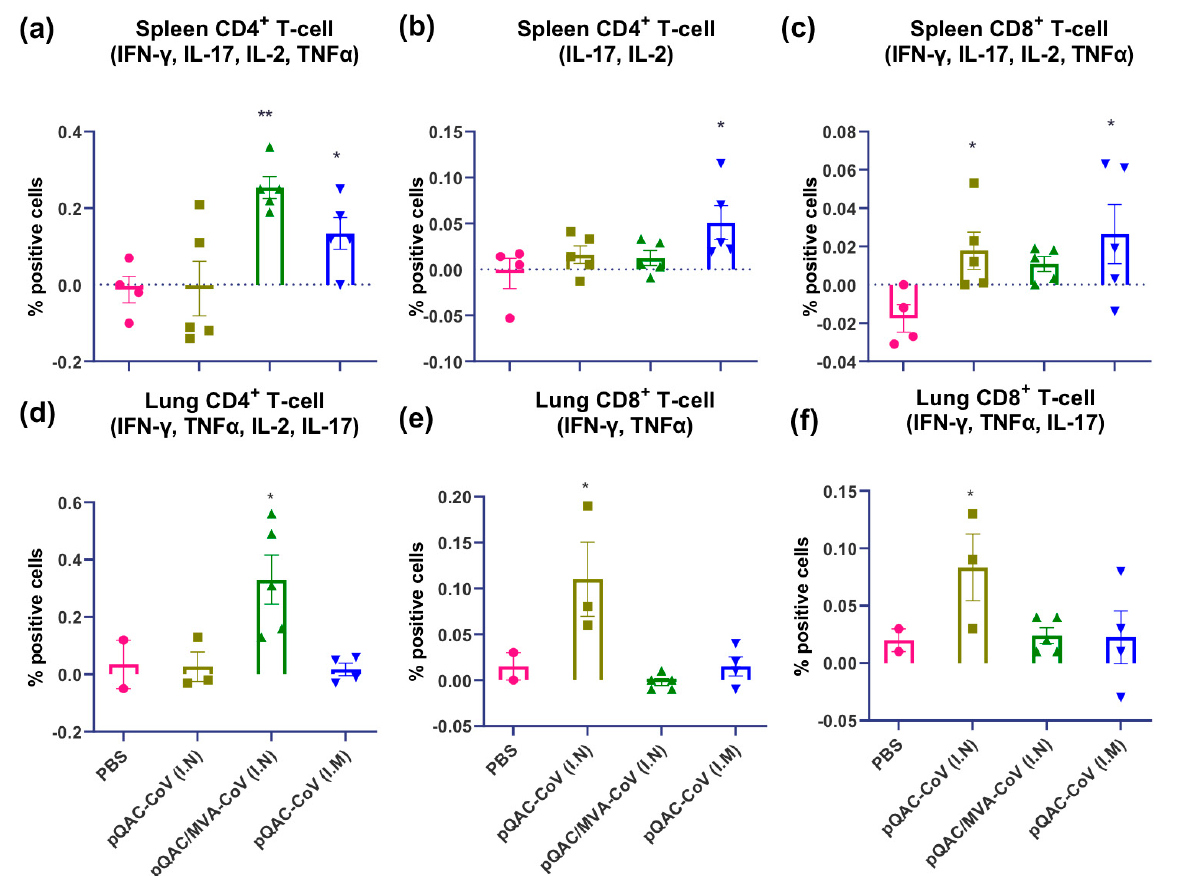
Figure 7. Immunization with SARS-CoV-2 vaccine constructs induces polyfunctional T cells. ( a ) CD4+ IFN- γ , TNF α , IL-2, and IL-17, ( b ) CD 4+ IL-2 and IL-17 ( c ) CD8+ IFN- γ , TNF α , IL-2, and IL-17 polyfunctional T-cells in the spleen of vaccinated mice. ( d ) CD4+ IFN- γ , TNF α , IL-2, and IL-17, ( e ) CD8+ IFN- γ and TNF α , ( f ) CD8+ IFN- γ , TNF α , and IL-17 polyfunctional T-cells in the lungs of vaccinated mice following intracellular cytokine staining assays for after recombinant SARS-CoV-2 spike stimulation. Significance (*, p < 0.05; **, p < 0.01) was determined by ANOVA compared to PBS controls. Data show mean ± SEM.